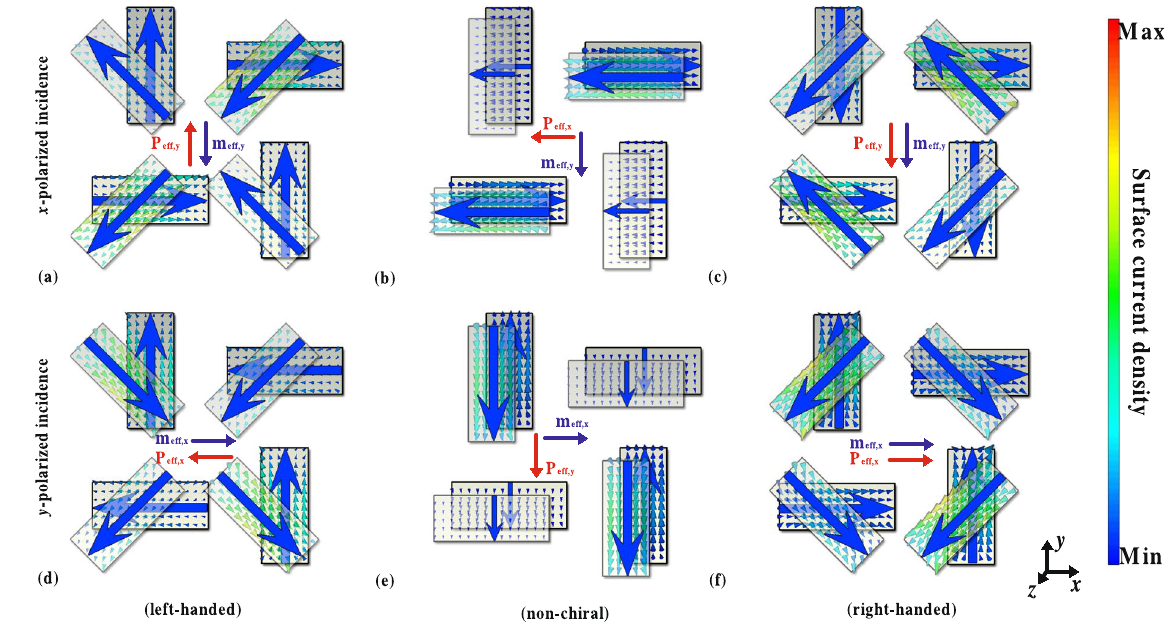
Figure 5. Simulated surface current distributions of the two-layer metasurfaces at 1670 nm. The surface current density for designed two-layer metasurfaces with orientation angle equal to ( a ) ( d ) 45°, ( b ) ( e ) 0° and ( c ) ( f ) − 45°, respectively with ( a – c ) x -polarized and ( d–f ) y -polarized incidence. The induced electric and magnetic dipoles have antiparallel components and parallel components for orientation angle equal to 45° and − 45° respectively, resulting in the opposite handedness of the two-layer